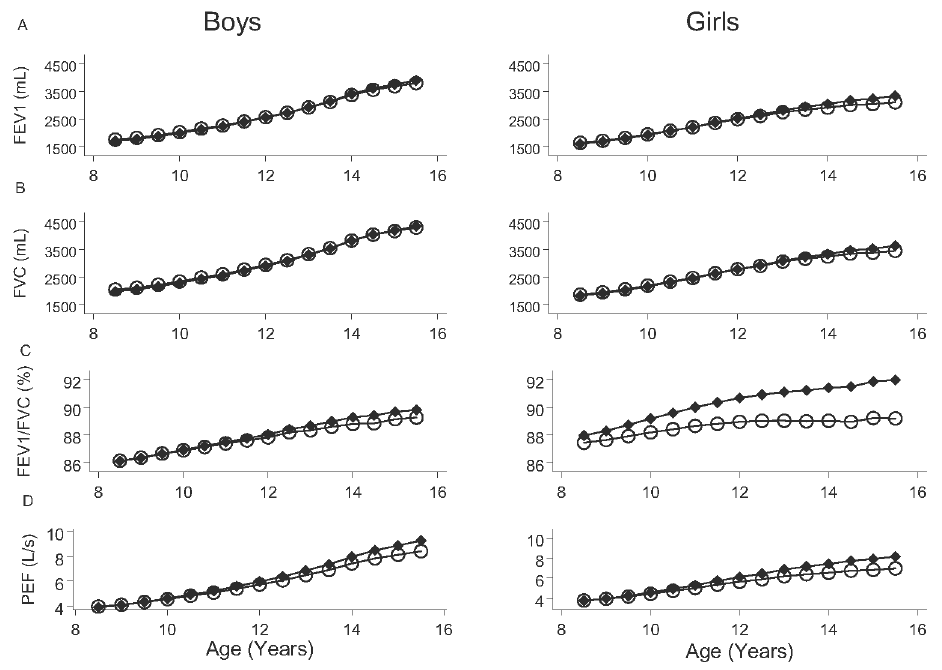
Figure 2. Lung function growth of a cohort of Mexican children as estimated by longitudinal models (full symbols) vs. cross-sectional models (empty symbols). Forced expiratory volume at 1 s (FEV ) (panel A), Forced vital capacity (FVC) (panel 1 B), the ratio of FEV and FVC (FEV /FVC) (panel C) and Peak expiratory flow (PEF) (panel D) vs. age in years of children from 1 1 Mexico City as expressed in mL (FEV and FVC) or in percentage (FEV /FVC) for mean age, mean height, and mean weight of 1 1 children, for longitudinal growth (full circles) or cross-sectional models (empty circles). Estimates from the cross-sectional model and the longitudinal model depart during follow-up for FEV /FVC, as do the values at the end of follow-up, especially for girls. 1 doi: